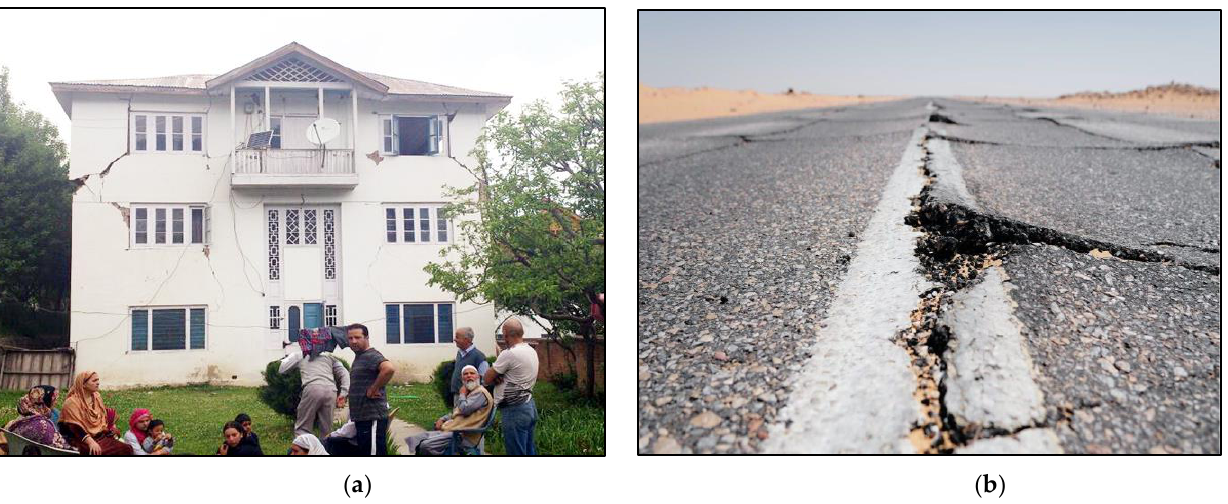
Figure 8. ( a ) Building cracks appeared as a result of the earthquake in the areas around the Jammu region source: Ref. [64]. ( b ) Crack on road due to an earthquake in the region in February 2022 adapted from source: Ref. [65]. Table 1. List of past Earthquakes experienced in the study region. S.